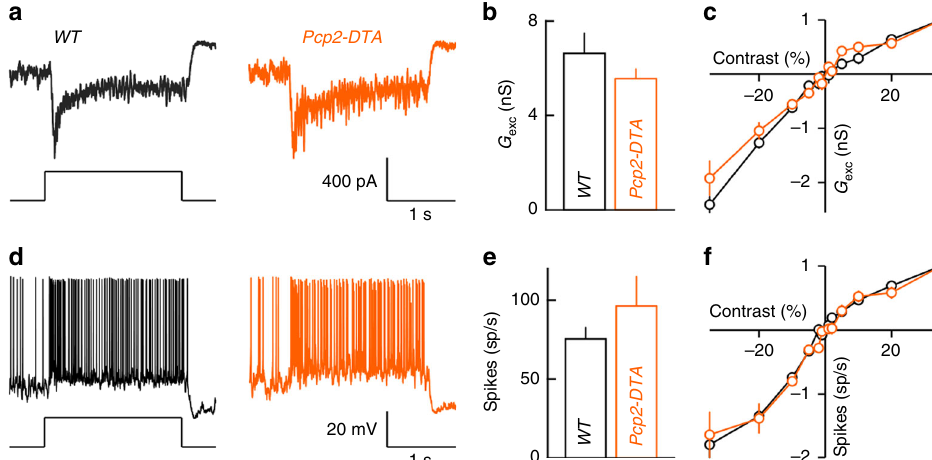
Fig. 7 Excitatory input and spike responses of ON α -RGCs in wild-type and Pcp2-DTA mice. a EPSC responses to dim light steps (three rhodopsin isomerization/rod/s, 3 R*) recorded from ON α -RGCs in wild-type (left, black) and Pcp2-DTA (right, orange) retinas. b Summary data (mean ± SEM) of the excitatory conductances elicited by dim light steps (as shown in a ) in ON α -RGC of wild-type (black, n = 7 cells, n = 2 mice) and Pcp2-DTA (orange, n = 6 cells, n = 2 mice, p > 0.5 by Wilcoxon rank sum test) mice. c Population data for contrast response functions of excitatory conductances of ON α -RGCs recorded in wild-type (black, n = 6 cells, n = 2 mice) and Pcp2-DTA (orange, n = 3 cells, n = 2 mice, p > 0.1 by bootstrapping methods) retinas. d – f Analogous to a – c , but for spike responses instead of excitatory inputs. Responses to dim light steps (wild type n = 9 cells, n = 2 mice Pcp2-DTA n = 5 cells, n = 2 mice, p > 0.3 by Wilcoxon rank sum test), and contrast response functions (wild type n = 6 cells, n = 2 mice, Pcp2-DTA n = 3 cells, n = 2 mice, p > 0.3 by bootstrapping methods) were not signi fi cantly different between wild-type and Pcp2-DTA